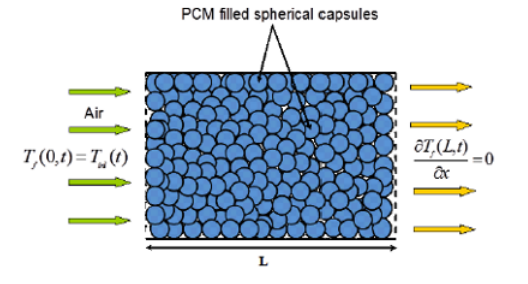
Fig. 1. Schematic of the packed